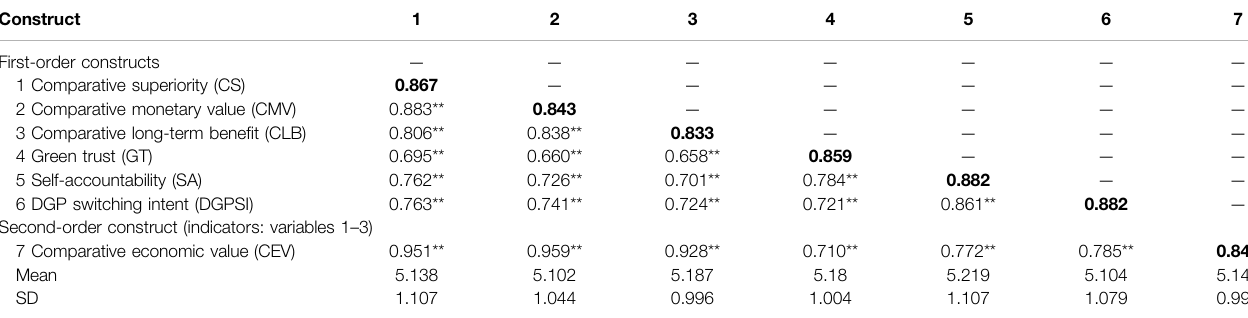
TABLE 2 | Descriptive statistics and Pearson ’ s correlations ( N (cid:1) 317).